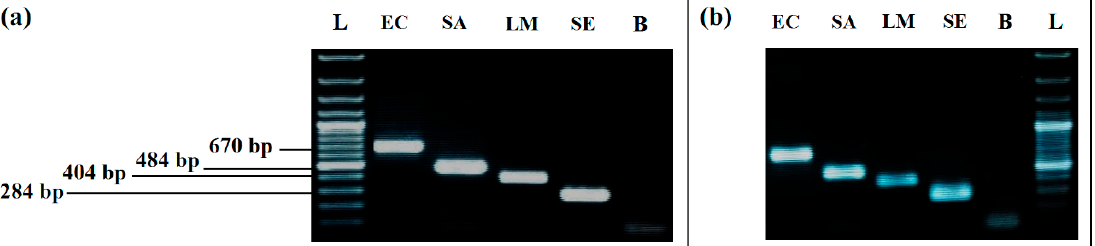
Figure 1. Comparison of the two DNA extraction methods effect on PCR detection: ( a ) simplex PCR with DNA extracted by GenElute™ bacterial genomic DNA Extraction kit, with lysozyme. ( b ) simplex PCR with DNA extracted by thermal lysis protocol, without lysozyme. L, 100 bp DNA ladder; EC, E. coli (8.55 × 10 8 CFU/mL); SA, S. aureus (3.27 × 10 8 CFU/mL); LM, L. monocytogenes (2.1 × 10 7 CFU/mL); SE, S. enterica (2.2 × 10 8 CFU/mL); L, 100 bp DNA ladder; B, negative control.